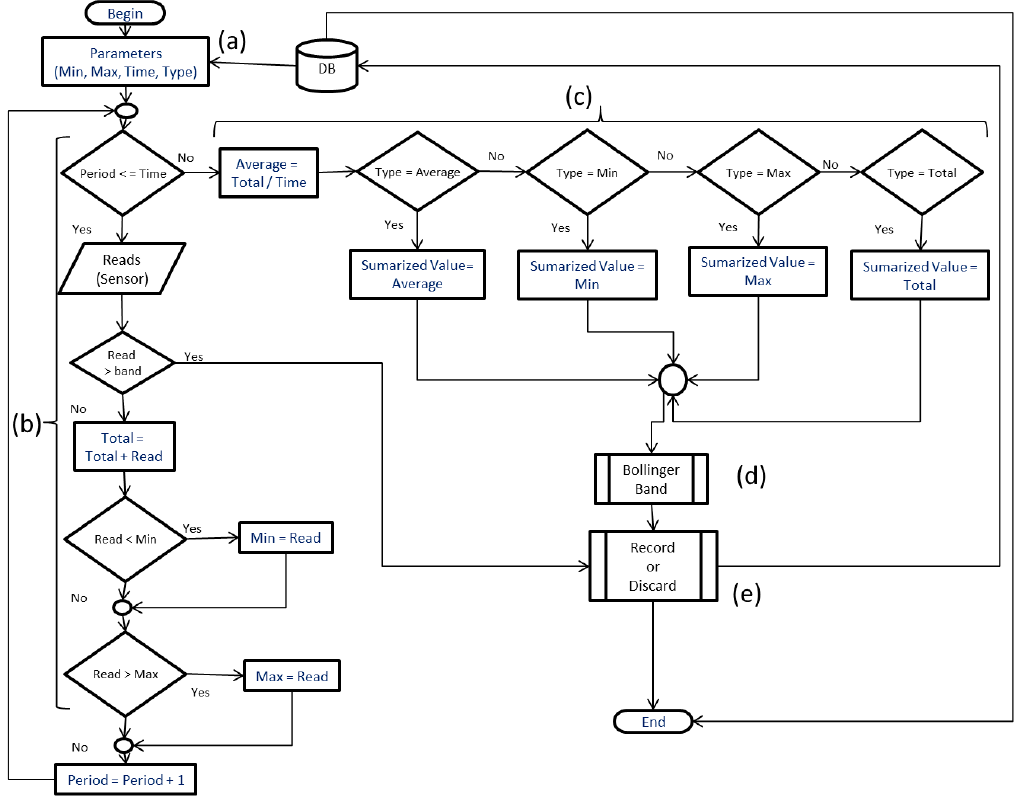
Figure 3. The proposed summarization algorithm in the node.